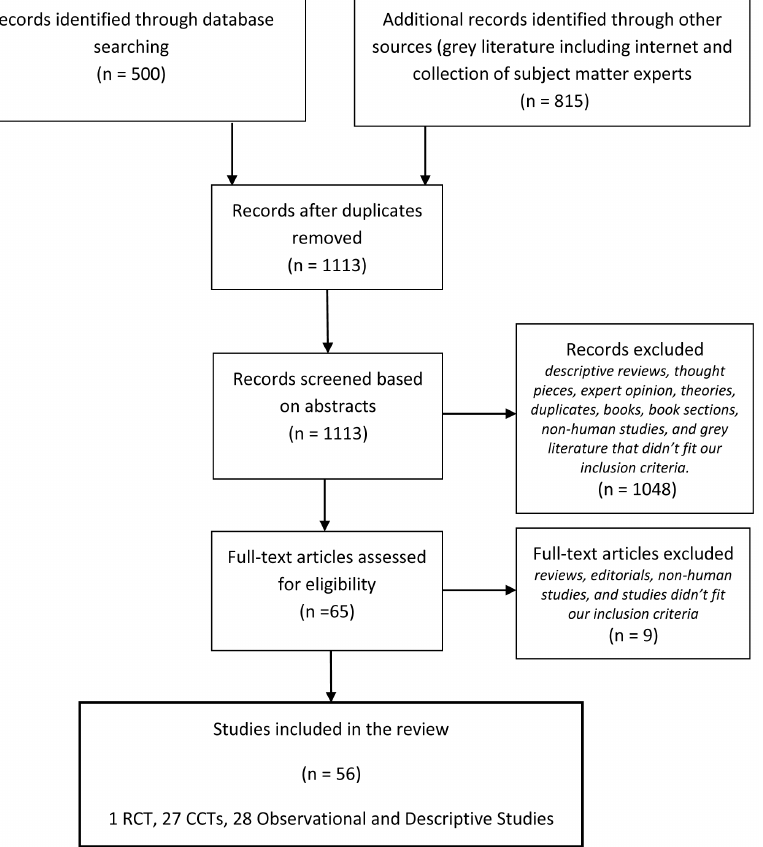
Figure 2. Flow chart. There were a total of 1315 records identified through the literature search, out of which 1113 were screened based on abstracts after removal of duplicates. The first level of screening based on abstracts resulted in exclusion of 1048 records (descriptive reviews, editorials, theories, books, book sections, non-human studies, and grey literature that didn’t fit our inclusion criteria), and the second level of screening based on full-text resulted in exclusion of 9 more additional records. Therefore, a total of 56 studies (1 randomized controlled clinical trial, 27 controlled clinical trials, and 28 observational/descriptive studies) were included in this review.